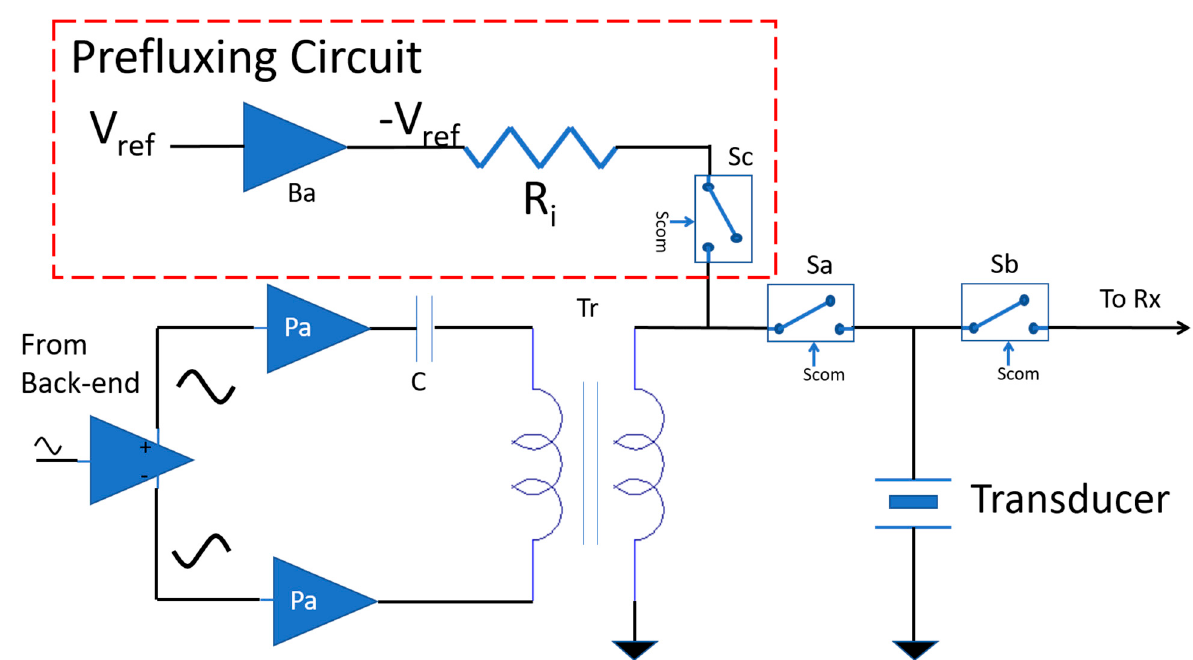
Figure 5. Architecture of the transmitter circuit with the added prefluxing circuit (dashed-red box). A couple of power amplifiers (Pa) apply complementary signals to the transformer coil. The Sa switch is closed during transmission, while Sc and Sb are closed during reception. During reception, the prefluxing circuit charges the magnetization inductance to - Vref/ 𝑅𝑖 current; during transmission, this current decays towards 0.